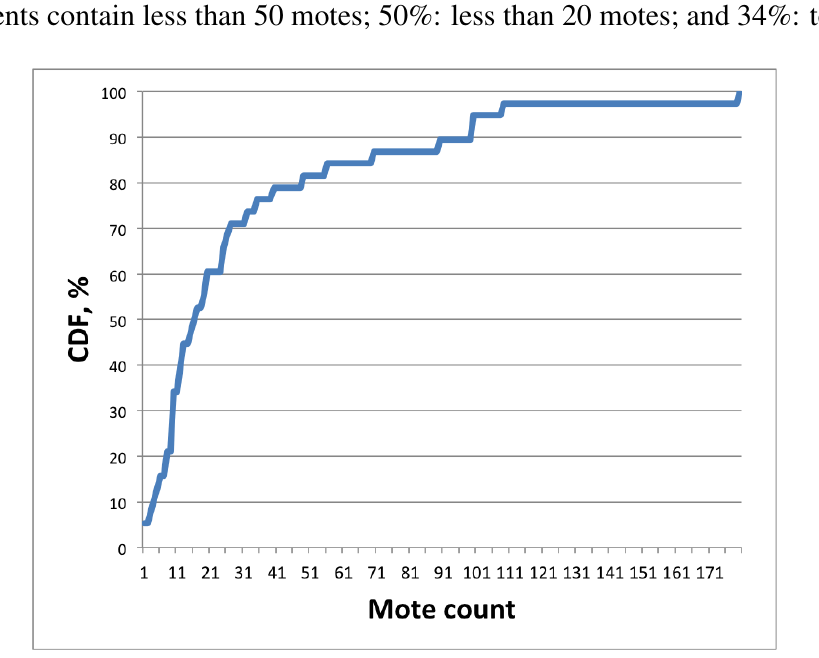
Figure 1. Distribution function of mote count in surveyed deployments —Eighty percent of deployments contain less than 50 motes; 50%: less than 20 motes; and 34%: ten or